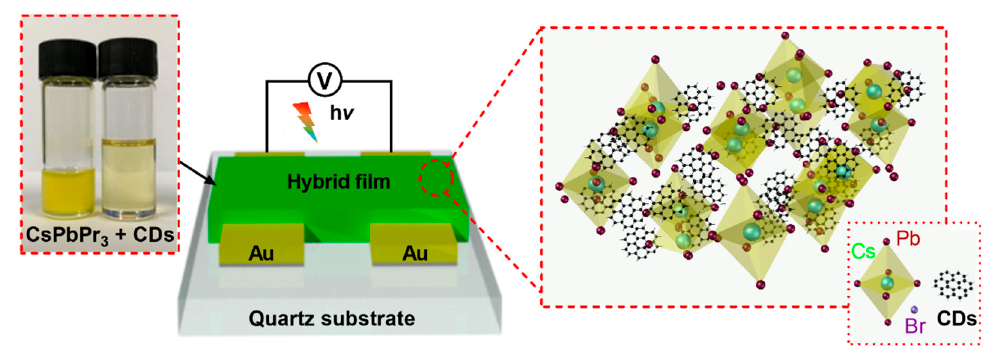
Figure 1. Schematic of the device structure and composite materials.